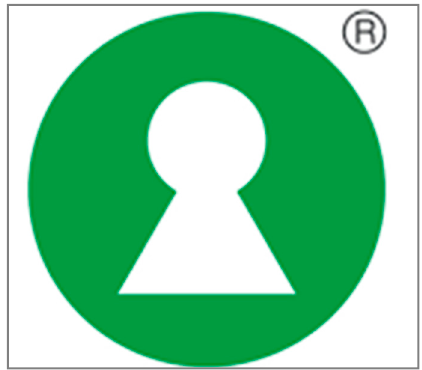
Figure A8. KeyHole (Nordic Europe) labels food that contains fewer sugars and salt, more fibre and